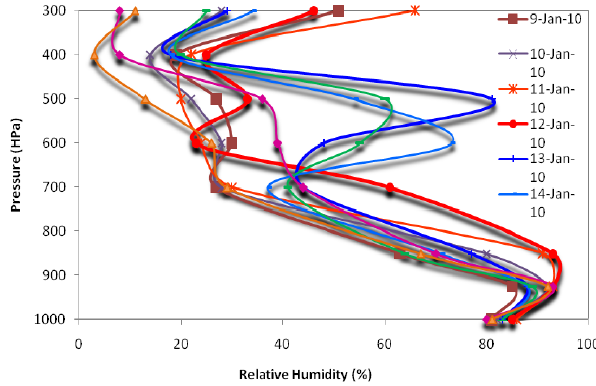
Figure 3d. Vertical variation of relative humidity for the period 9-17 January, 2010, the relative humidity shows a characteristic varitionn of relative humidity on the day of earthquake.